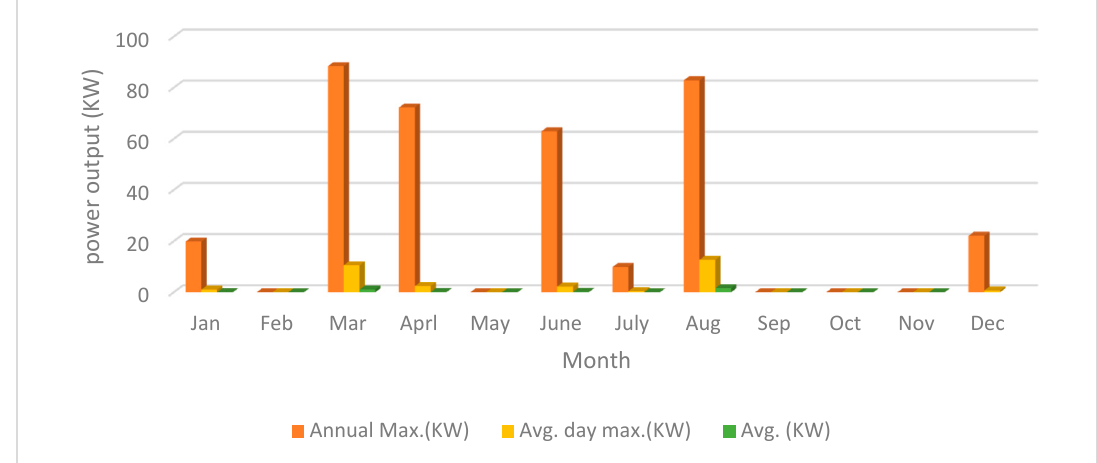
Figure 8. Monthly genset power output (KW).